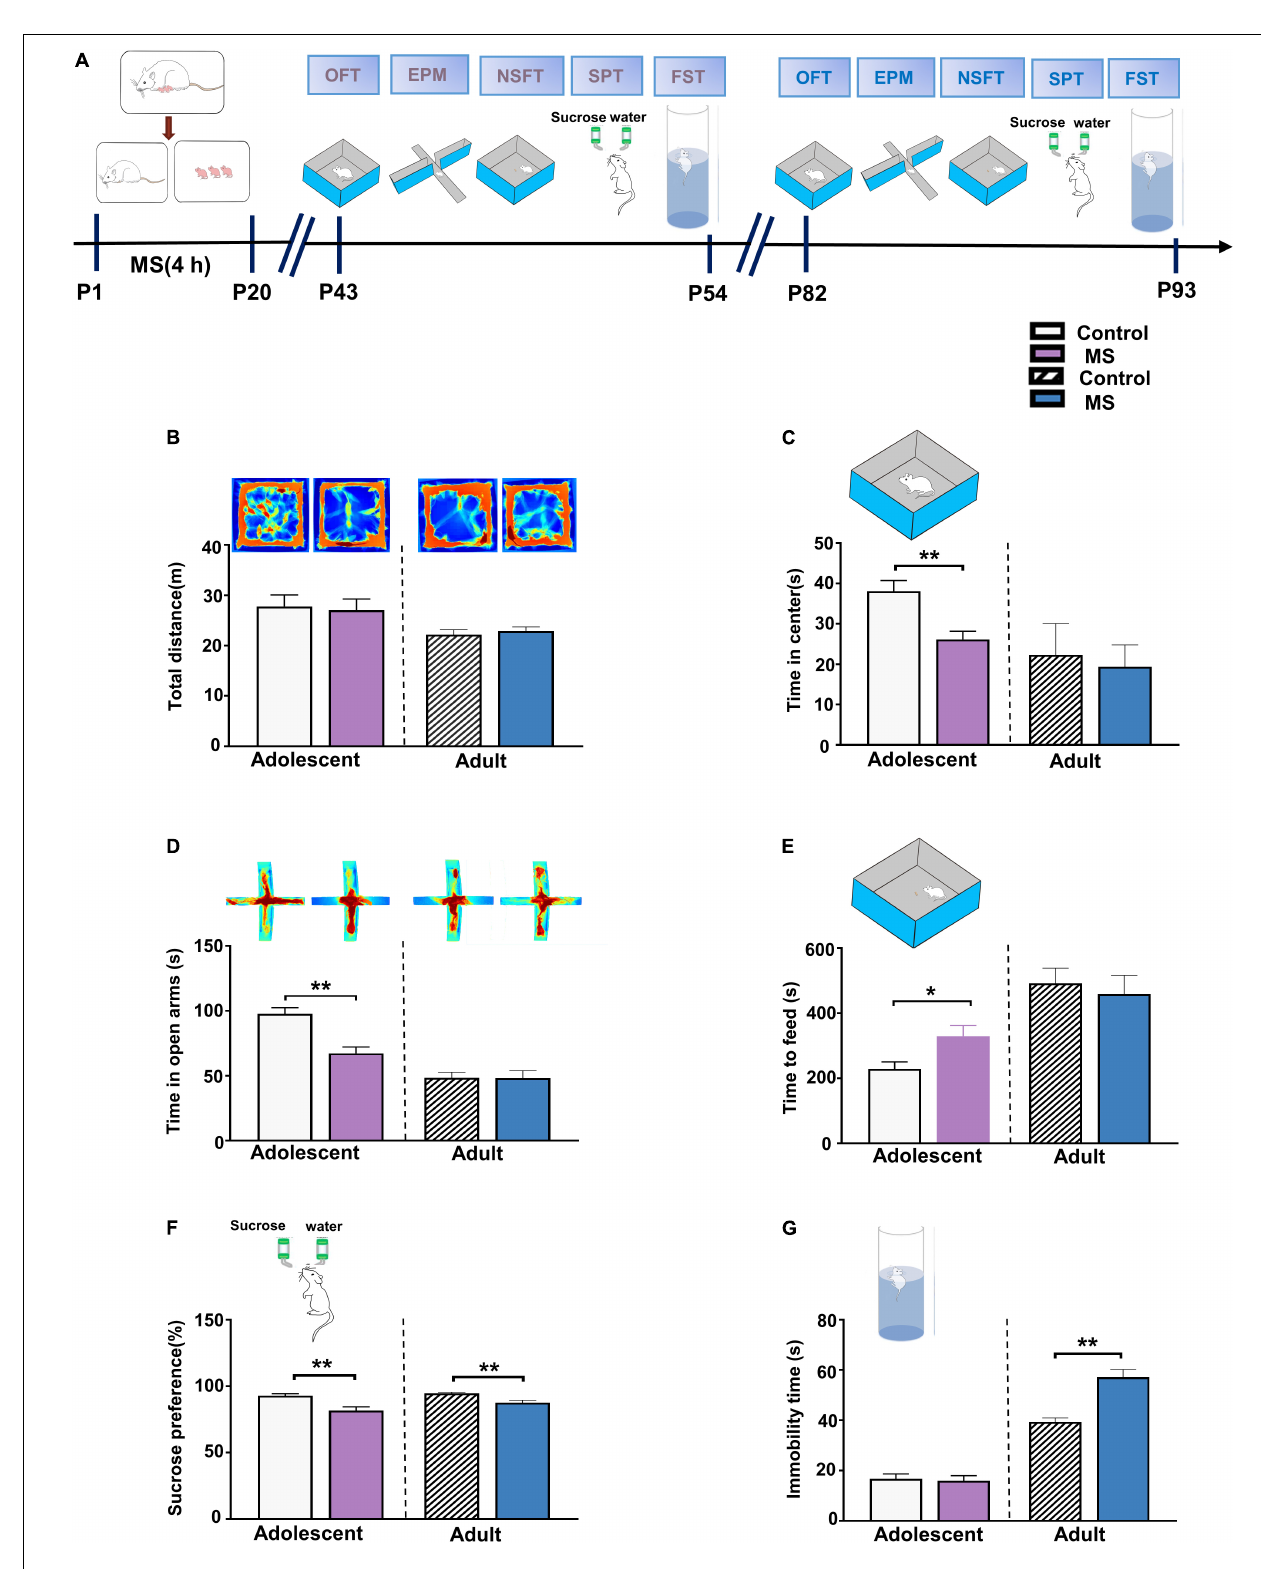
FIGURE 1 | Maternal separation induces different behaviors in adolescent and adult rats. (A) The experimental timeline of MS, behavioral tests. (B) Upper: representative traces of the movement of adolescent and adult rats in the open field experiment. Lower: the total distance in the open field experiment of